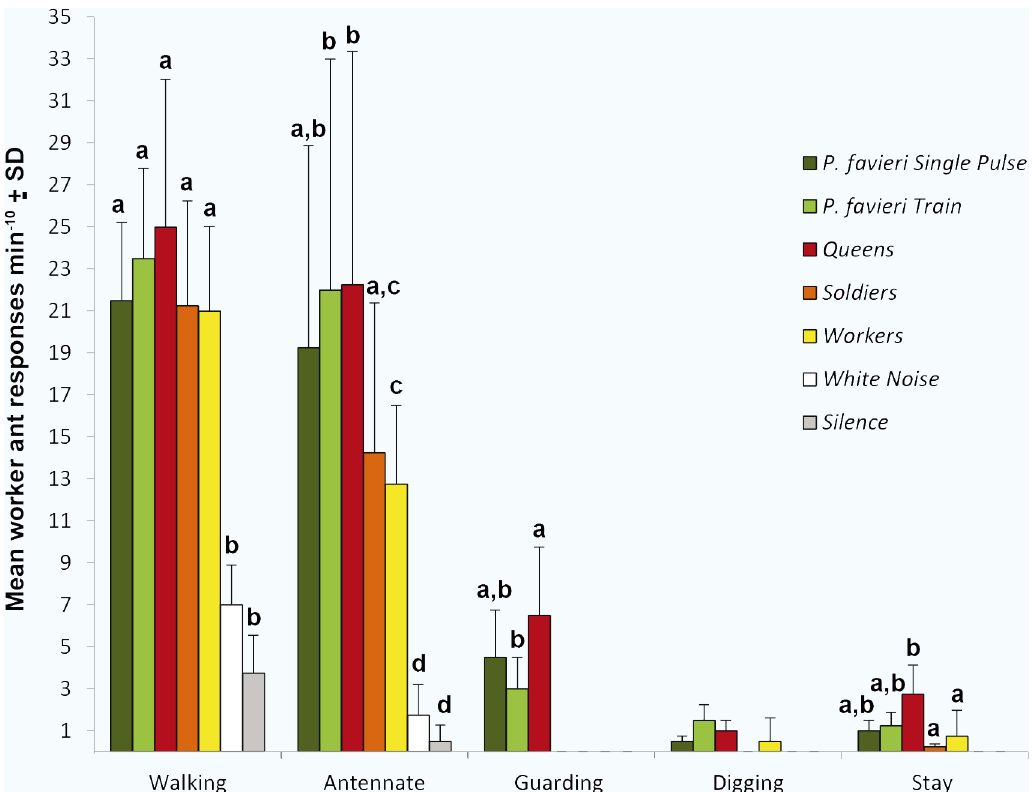
Fig 4. Playback experiments. Behavioural responses of Pheidole pallidula colonies to sound recordings of Paussus favieri (single pulses), P . favieri (trains), Pheidole pallidula queens, P . pallidula soldiers, P . pallidula workers, and to two controls (white noise and silence) are shown. Five benevolent behaviours were observed; no antagonistic behaviour was observed. GLM testing for the effect of sounds and colony showed a significant overall difference in responses occurred within five behaviours (N = 140; Walking: F stimuli = 22.623, df = 6, P < 0.001, F nest = 1.253, df = 9, P = 0.284; Antennate: F stimuli = 39.414, df = 6, P < 0.001, F nest = 1.221, df = 9, P = 0.302; Guarding: F stimuli = 12.942, df = 6, P < 0.001, F nest = 1.388, df = 9, P = 0.216; Digging: F stimuli = 2.667, df = 6, P = 0.024, F nest = 0.667, df = 9, P = 0.735; Staying: F stimuli = 5.083, df = 6, P = 0.004, F nest = 1.856, df = 9, P = 0.079). The letters above each column indicate significance ( P < 0.05) in pairwise post hoc Tukey tests. The same letter indicates no significant difference within each type of behaviour.